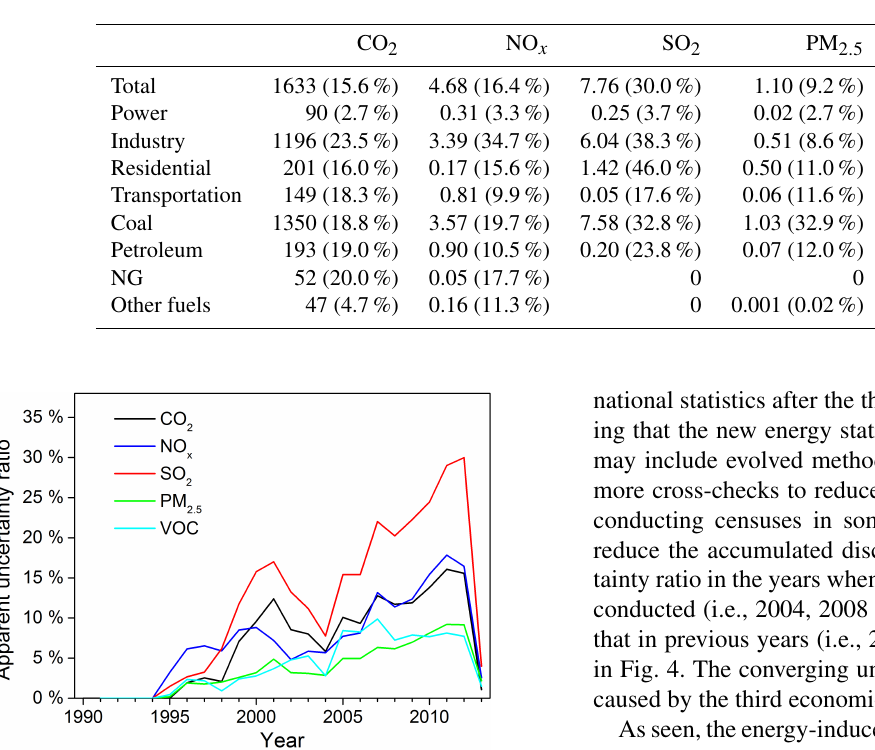
Table 2. Apparent uncertainties in China’s emissions in 2012 by sector and energy type. The apparent uncertainties are expressed in units of teragrams (Tg). The percentages shown in parentheses indicate the apparent uncertainty ratios. Note that the emission uncertainties shown here are only those associated with energy uncertainties.